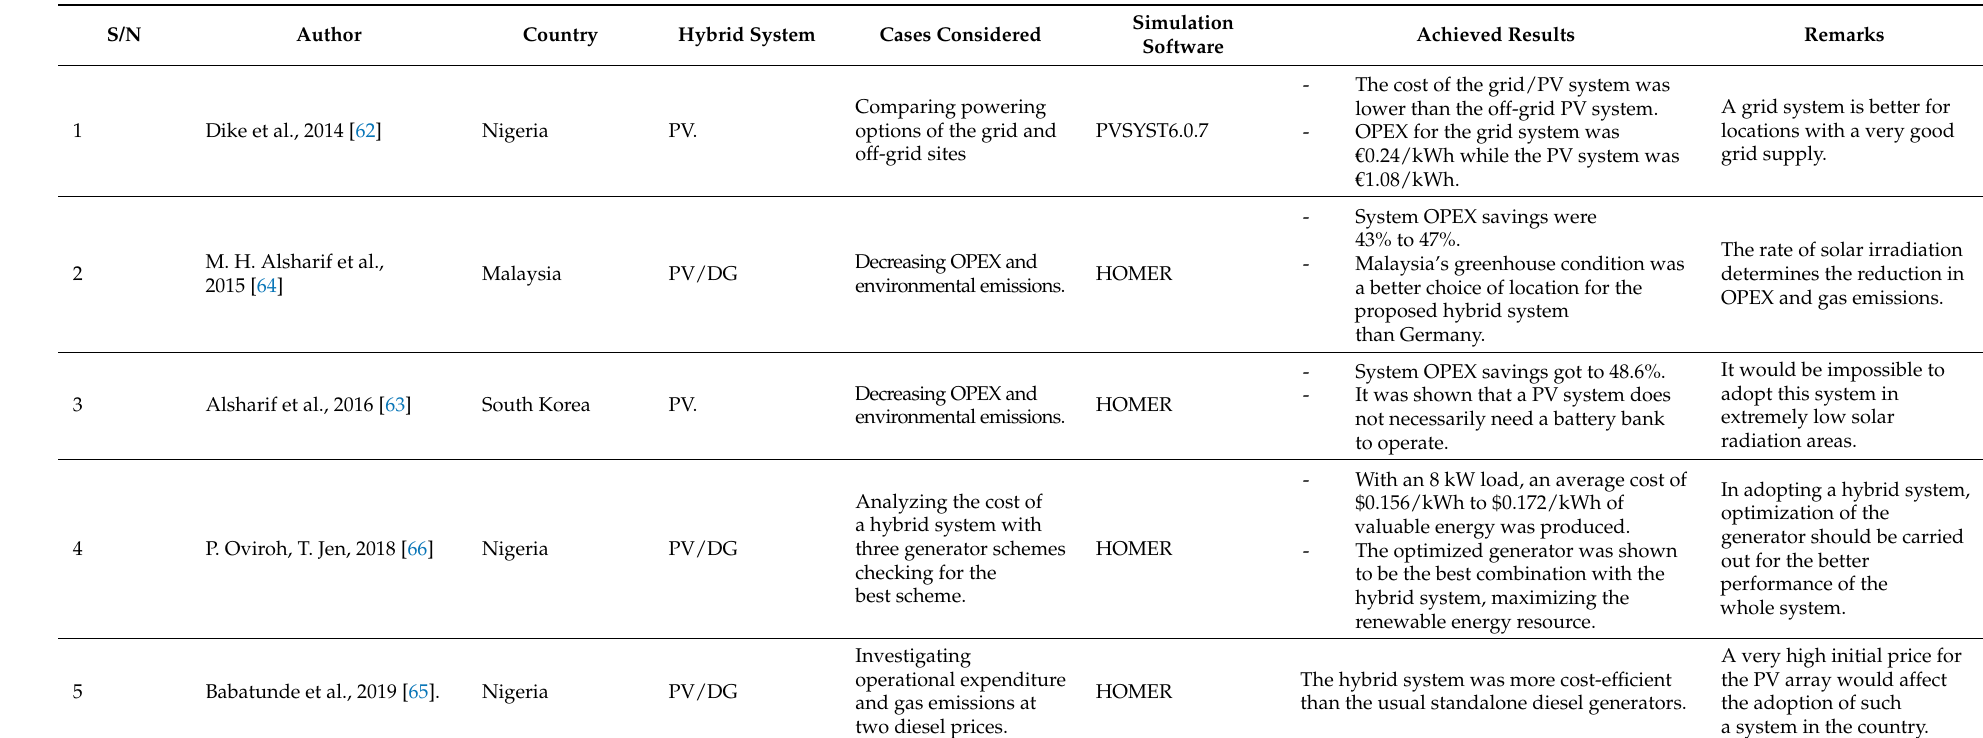
Table 2. Summary of related work utilizing renewable energy systems in base